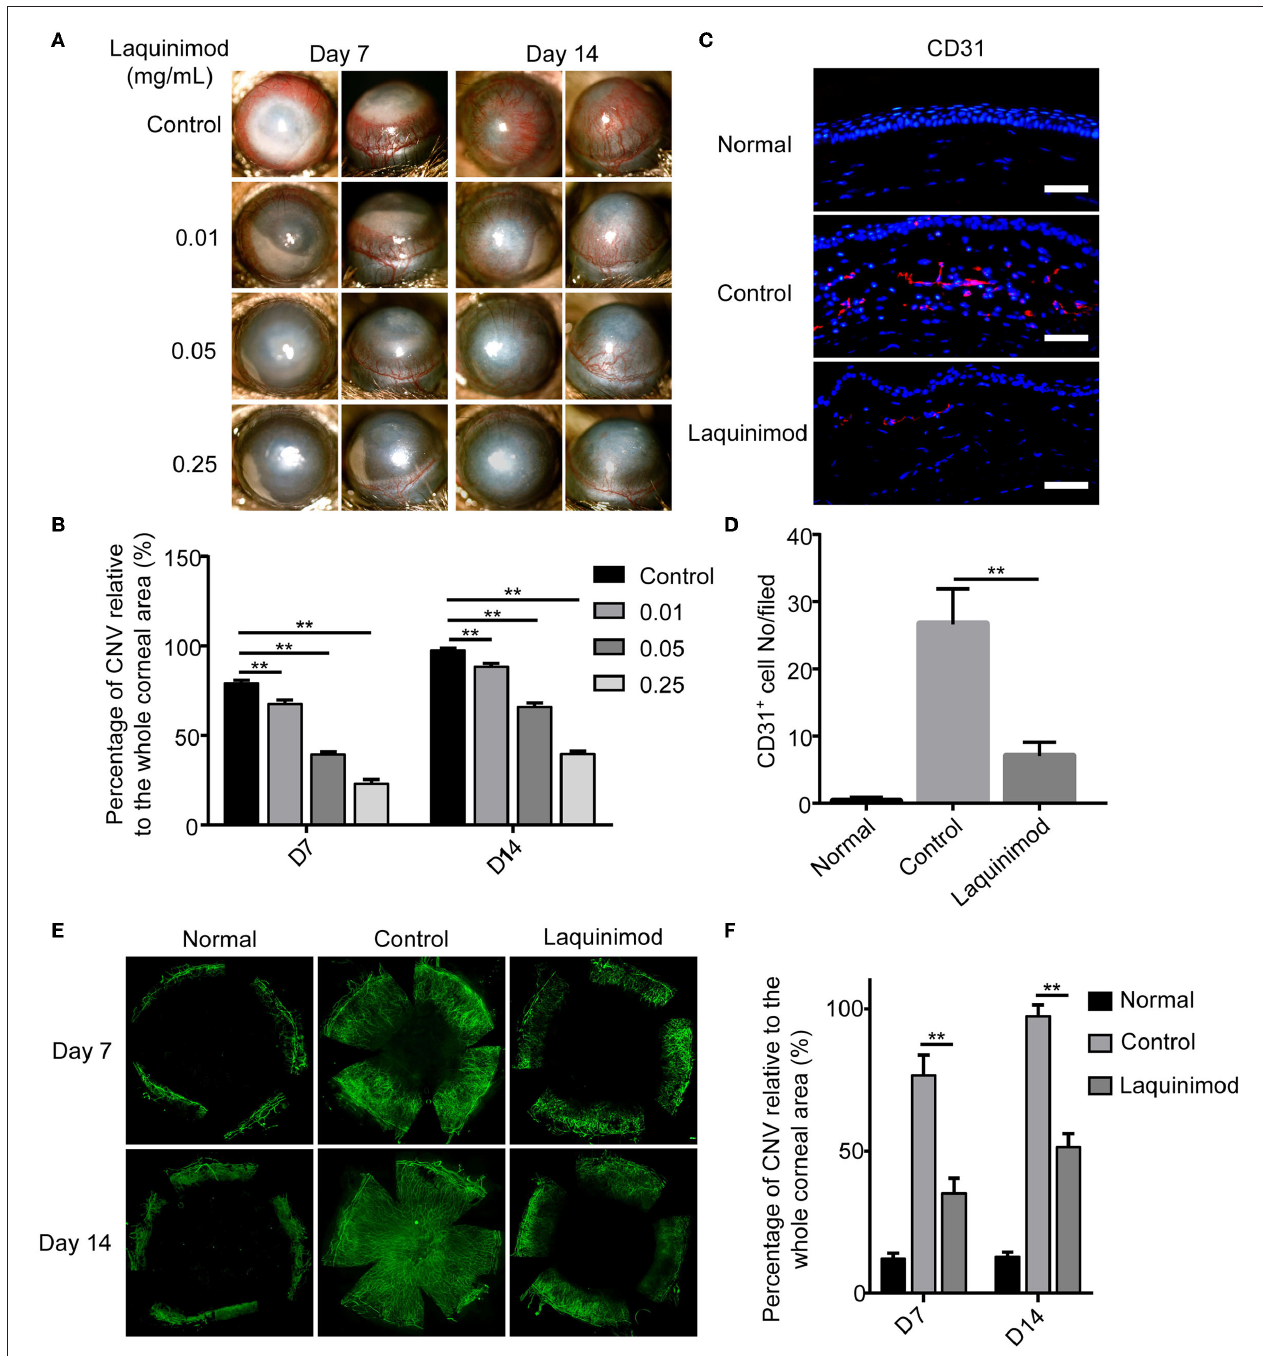
FIGURE 1 | Topical laquinimod application attenuated CNV. (A) Five microliters of laquinimod (0.01, 0.05, and 0.25 mg/mL) was topically applied to alkali-injured corneas twice a day. Images were taken with a slit lamp to show the frontal (left panels) and lateral (right panels) views of each eye. (B) The area of CNV was normalized to the entire cornea on the 7 and 14th days after alkali injury. (C) Five microliters of PBS or laquinimod (0.25 mg/mL) was topically applied to alkali-treated eyes twice a day. The eyes were harvested on the 7th day after alkali injury. Corresponding cryosections from treated corneal tissues were stained with an anti-CD31 antibody. Original magnification: 200 × . Scale bars = 50 µ m. (D) Quantitative analysis of the data presented in (C) . (E) Five microliters of PBS or laquinimod (0.25 mg/mL) was topically applied to alkali-treated eyes twice a day for 14 days. Corneas were dissected on the 7 or 14th day after alkali injury and stained with anti-CD31 antibody. Images of the flat mounts were captured with fluorescence microscopy. (F) The total corneal area and avascular area were calculated in a masked fashion using ImageJ software. And the ratio between the vascular area and total corneal area was used to assess CNV in different groups. The data represent the means ± S.E.M.s ( n = 6). PBS as control, ** p < 0.01, laquinimod vs. control.